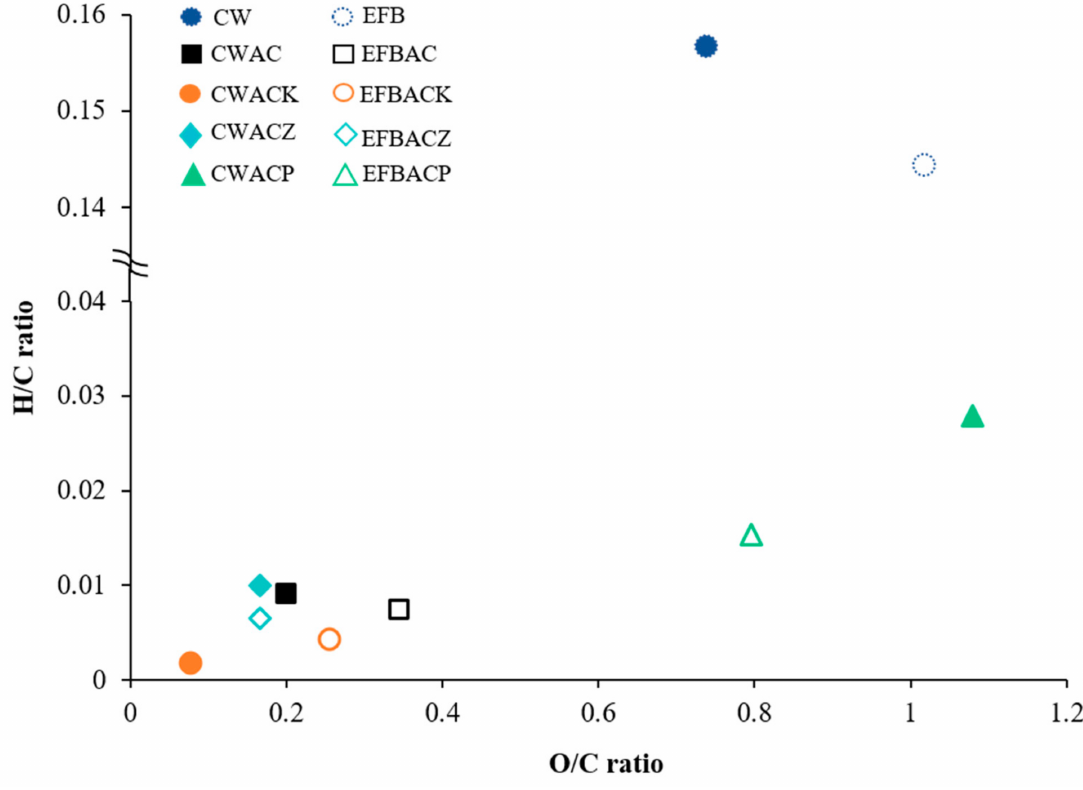
Figure 3. Van Krevelen diagram of feedstock and activated carbons prepared with various activating agents and carboniza- tion temperatures. Table 4. Thermal degradation analysis of activated